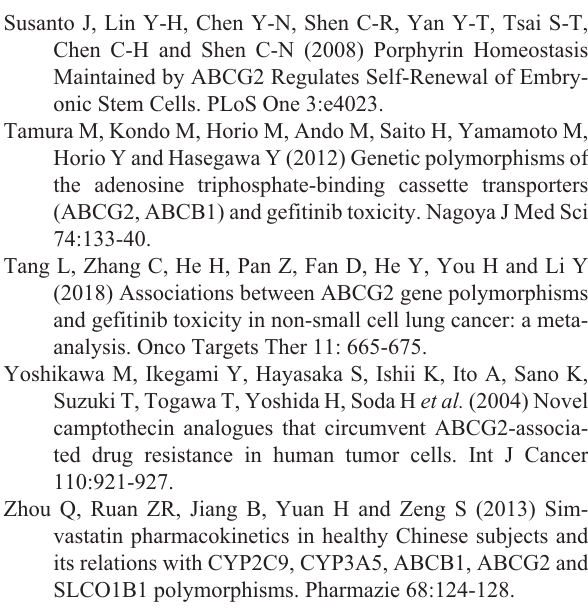
Figure S1 - Meta-analysis of ABCG2 gene polymorphisms and progression free survival after chemotherapy in the NSCLC for 421 CC/(AC+AA). Figure S2 - Meta-analysis of ABCG2 gene polymorphisms and overall survival after chemotherapy in the NSCLC for 421 CC/(AC+AA). Figure S3 - Meta-analysis of ABCG2 gene polymorphisms and mortality due to chemotherapy in the NSCLC for 421 CC/(AC+AA). Figure S4 - Meta-analysis of ABCG2 gene polymorphism and response to chemotherapy in the NSCLC for 34 GG/(GA+AA), and 421 CC/(AC+AA). Figure S5 - Meta-analysis of ABCG2 gene polymorphism and diarrhea due to chemotherapy in the NSCLC for 34 GG/(GA+AA), and 421 CC/(AC+AA). Figure S6 - Meta-analysis of ABCG2 gene polymorphism and skin toxicity due to chemotherapy in the NSCLC for 34 GG/(GA+AA), and 421 CC/(AC+AA). Figure S7 - Meta-analysis of ABCG2 gene polymorphism and liver dysfunction due to chemotherapy in the NSCLC for 34 GG/(GA+AA), and 421 CC/(AC+AA). Figure S8 - Meta-analysis of ABCG2 gene polymorphism and interstitial pneumonia due to chemotherapy in the NSCLC for 421